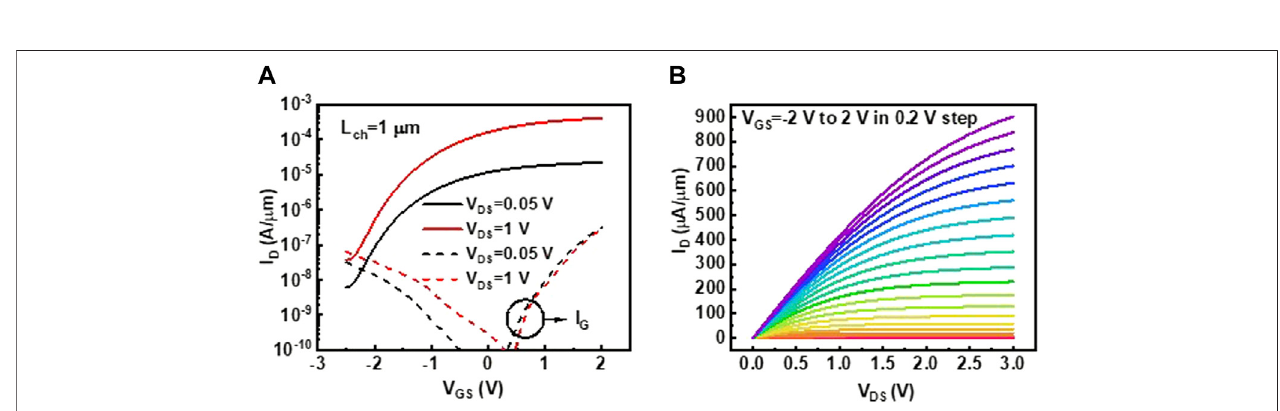
FIGURE1| Schematicdiagramof (A) anALDIn 2 O 3 transistorwith3.5 nmIn 2 O 3 asthechannelsemiconductorand3.5 nmHfO 2 asthegatedielectric; (B) thegate stack capacitor fabricated together with the ALD In 2 O 3 transistor.